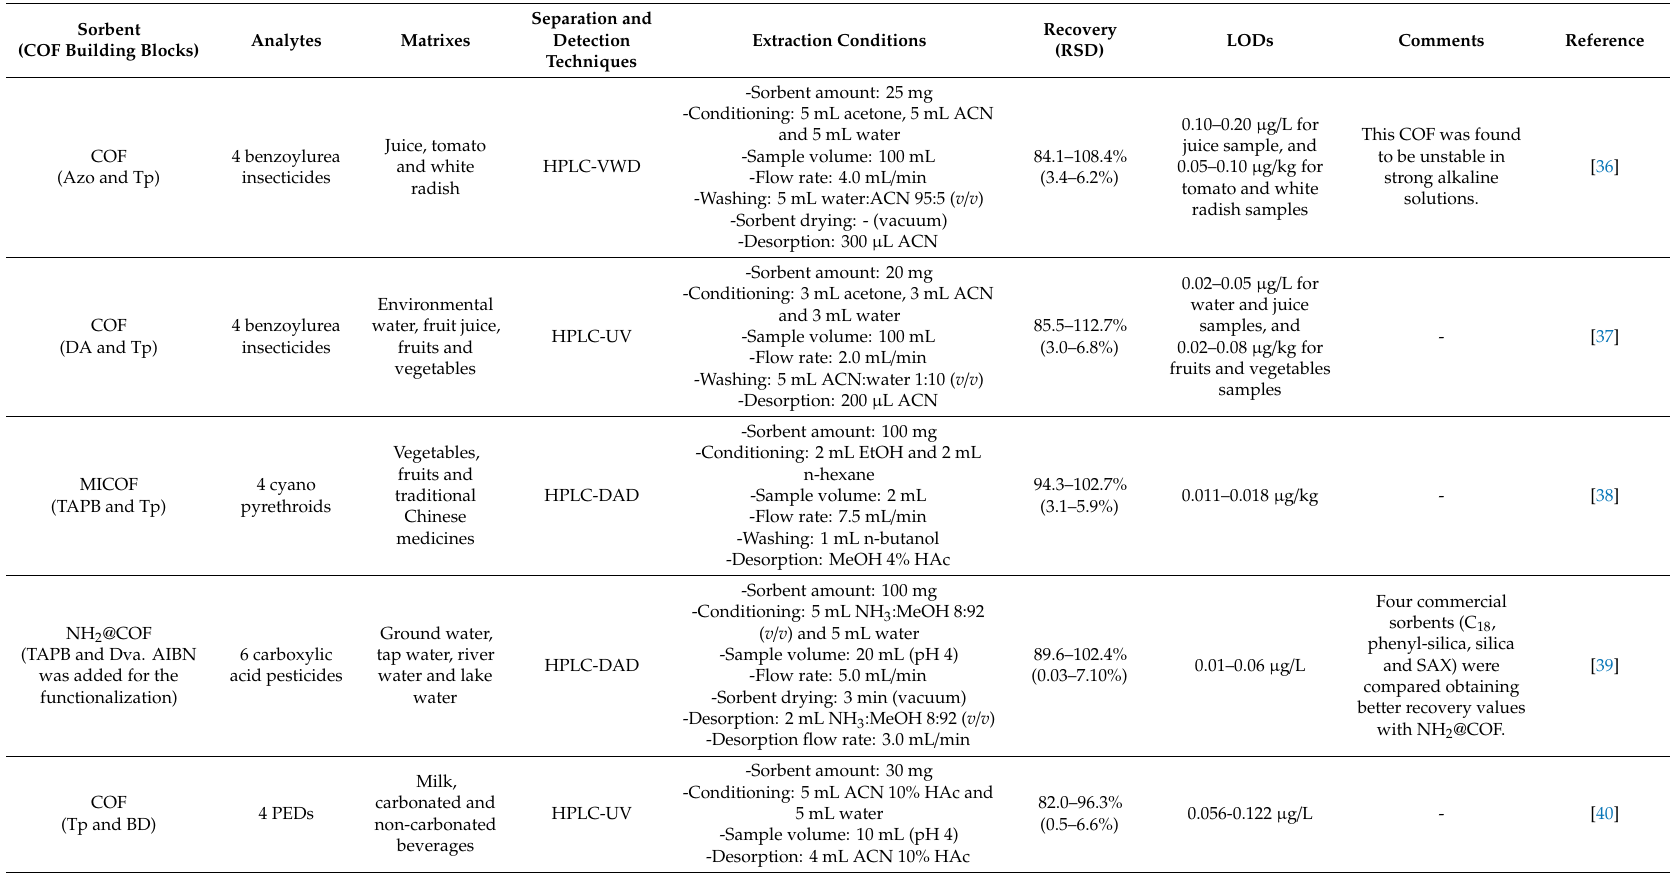
Table 1. Applications of COFs as sorbents in